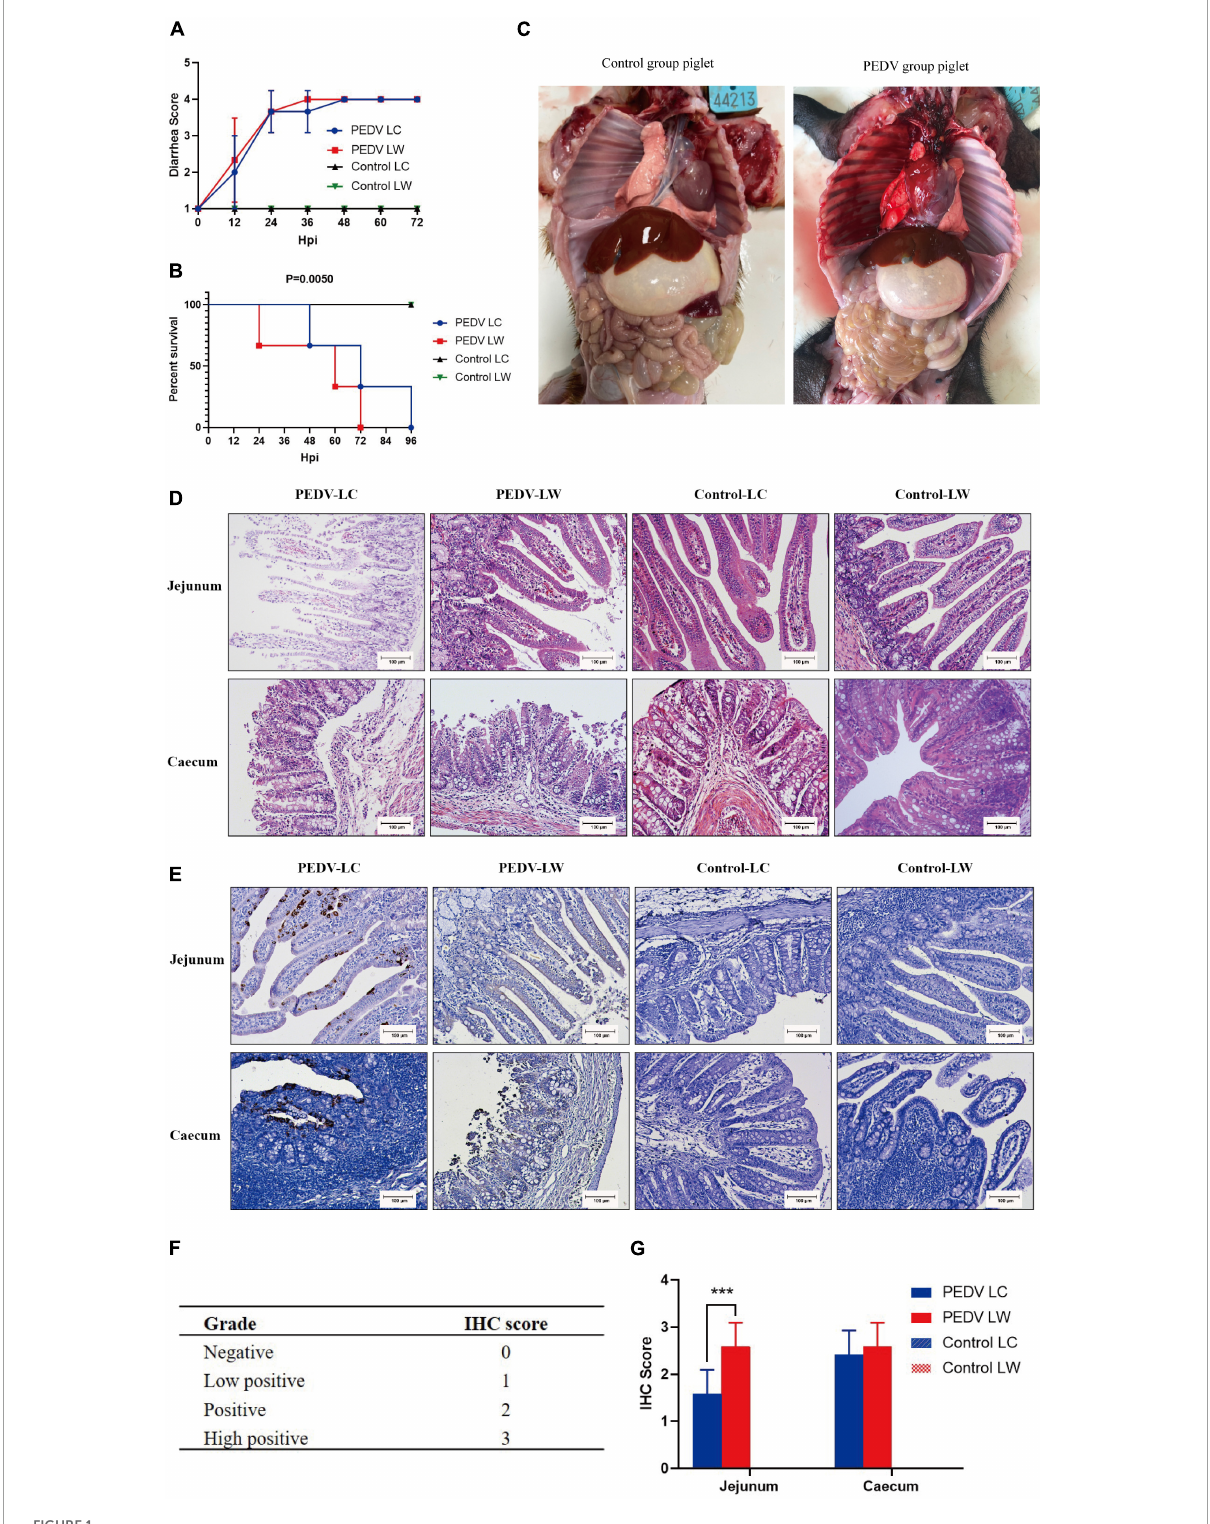
FIGURE1 (A) Diarrhea score of piglets. (B) Survival time of piglets. (C) Piglet autopsy lesions. (D) Intestinal H&E staining (100 µ m). (E) Immunohistochemical staining (100 µ m). (F) Immunohistochemistry scoring criteria. (G) Immunohistochemistry